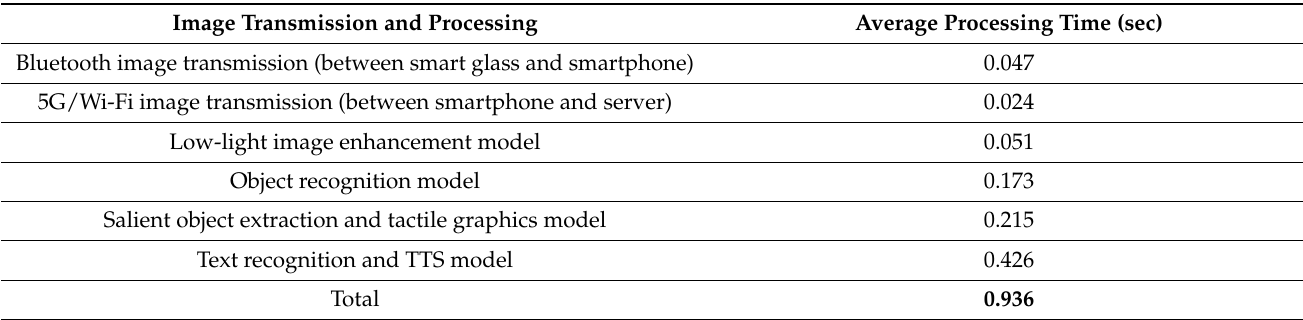
Table 8. The performance of average frame processing time (in seconds) per sequence. The average input image size is 640 × 456.